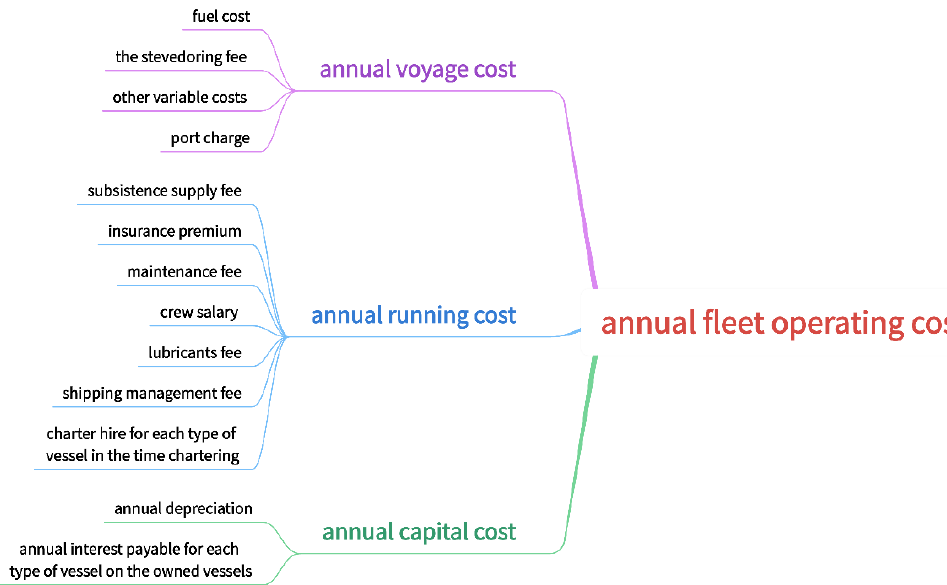
Figure 3. Framework of various cost